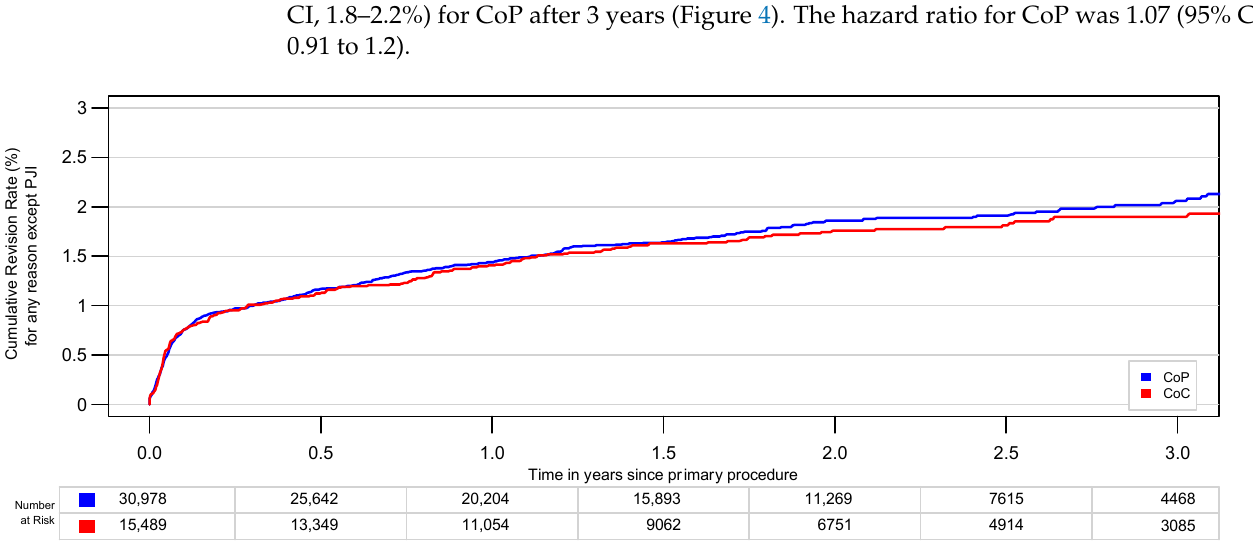
Figure 4. The cumulative risk of revision for any reason without PJI for CoP and CoC bearings after PSM (2:1) is not significantly different (p = 0.4).